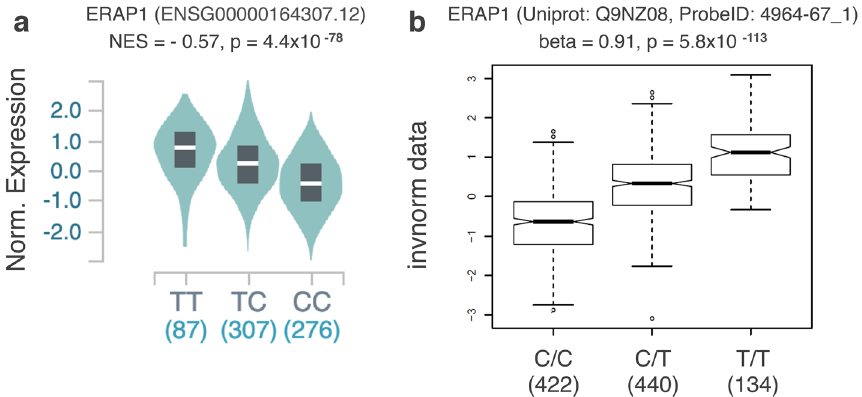
Figure 2. Effect of ERAP1 rs30187 variant on mRNA (Data source: GTEx) and protein levels (Data source: SNiPA) in blood. ERAP1 rs30187 CC genotype is associated with the lowest expression level. Each T allele additivelly increases ERAP1 mRNA in whole blood cells ( a ) and Erap1 protein concentration in plasma ( b ). NES: Normalized effect size; Norm. Expression: normalized expression; invnorm data: inverse-normal scaled data, ( b ) was kindly provided by Karsten Suhre from SNiPA team.